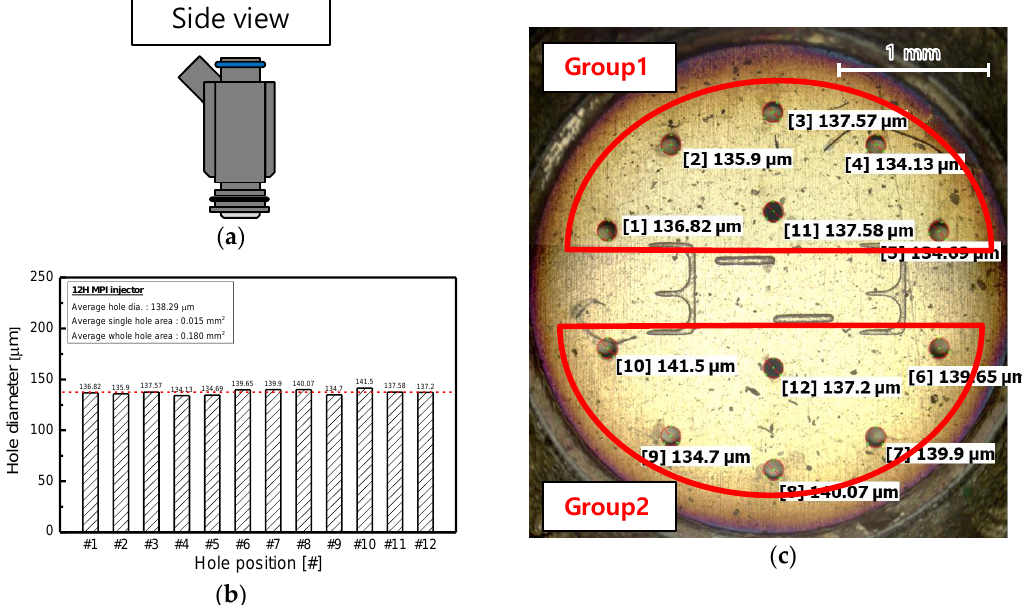
Figure 3. Specifications of PFI system used in experiment: ( a ) Schematic diagram of 12-hole PFI system, ( b ) measured each hole diameter, ( c ) close-up photograph of orifice using SEM.